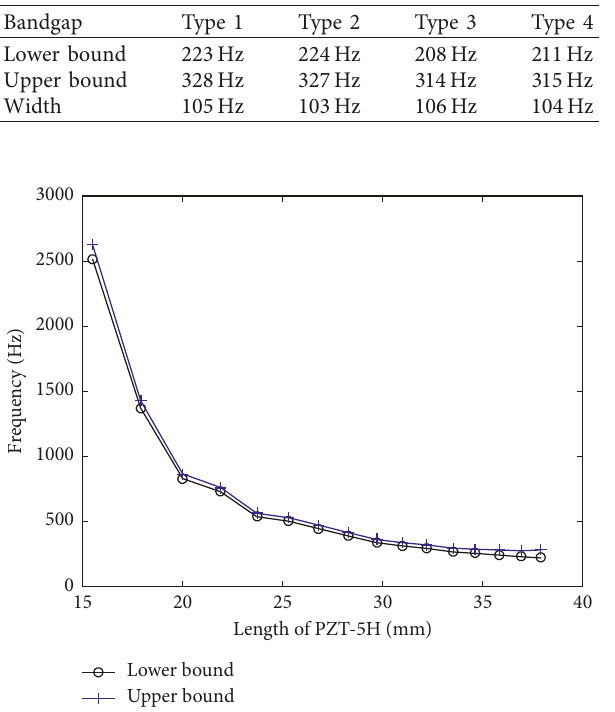
Figure 11: The lower and upper bound vs. the length of PZT-5H.